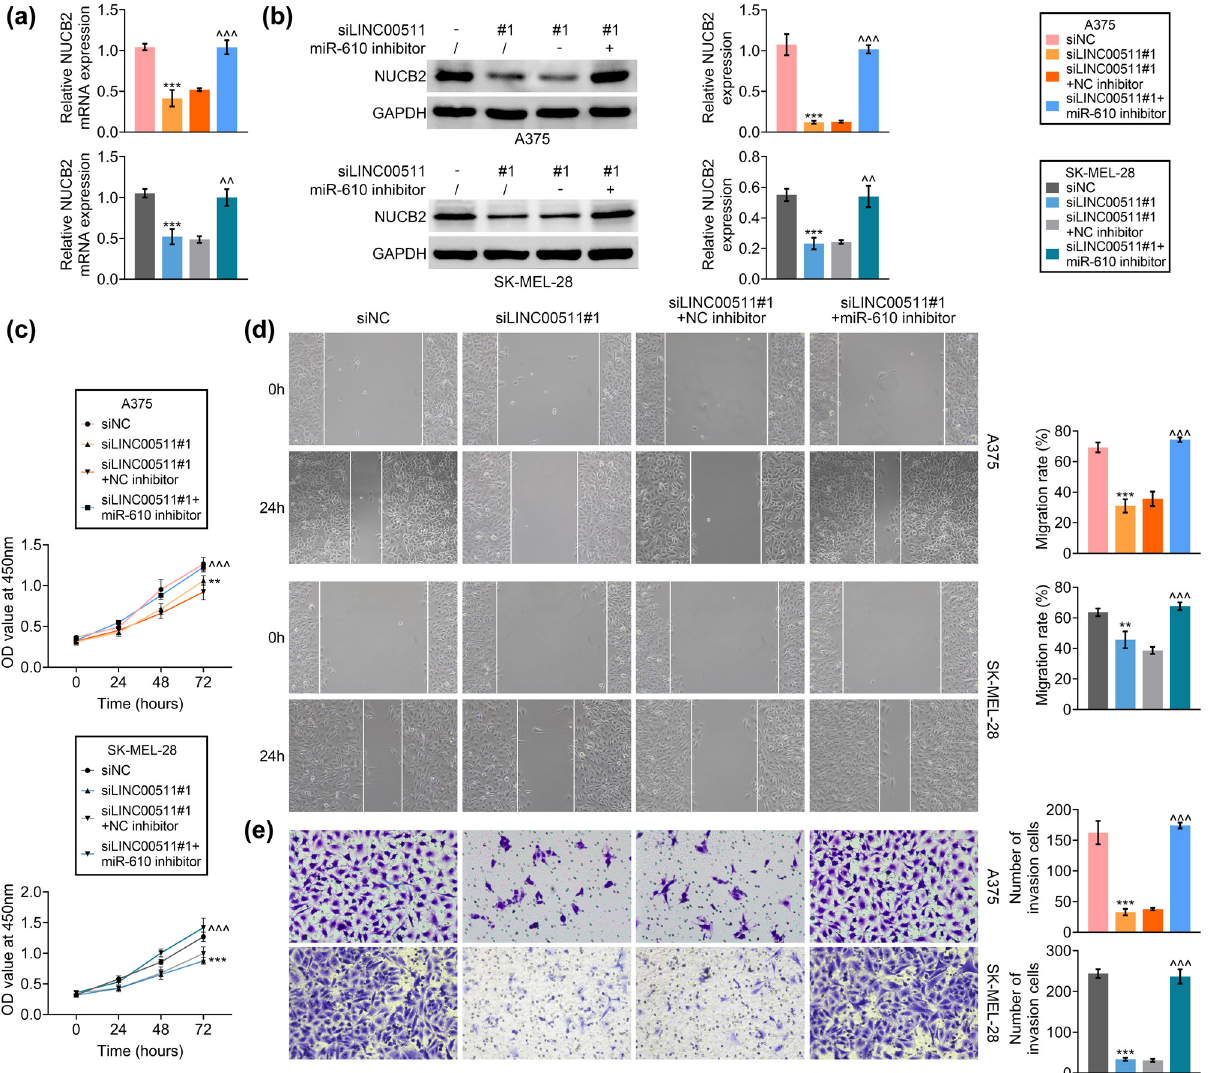
Figure 5: LINC00511 - promoted melanoma progression through the regulation of miR - 610/NUCB2. ( a ) Transfection with si LINC00511#1 reduced mRNA expression of NUCB2, while inhibition of miR - 610 attenuated LINC00511 de fi ciency - induced decrease of NUCB2 in A375 and SK - MEL - 28. ( b ) Transfection with si LINC00511#1 reduced protein expression of NUCB2, while inhibition of miR - 610 attenuated LINC00511 de fi ciency - induced decrease of NUCB2 in A375 and SK - MEL - 28. ( c ) Loss of miR - 610 also weakened LINC00511 de fi ciency - induced decrease of cell viability in A375 and SK - MEL - 28. ( d ) Loss of miR - 610 also weakened the LINC00511 de fi ciency - induced decrease of cell migration in A375 and SK - MEL - 28. ( e ) Loss of miR - 610 also weakened the LINC00511 de fi ciency - induced decrease of cell invasion in A375 and SK - MEL - 28. *** vs si LINC00511#1, p < 0.001. ^^, ^^^ vs NC, p < 0.01, p <